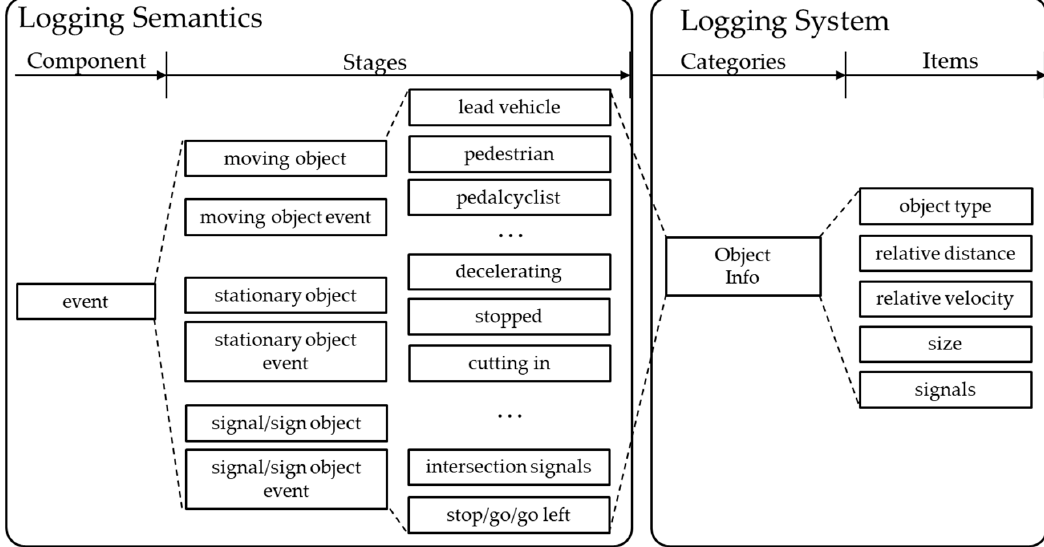
Figure 7. Event components and logging items.